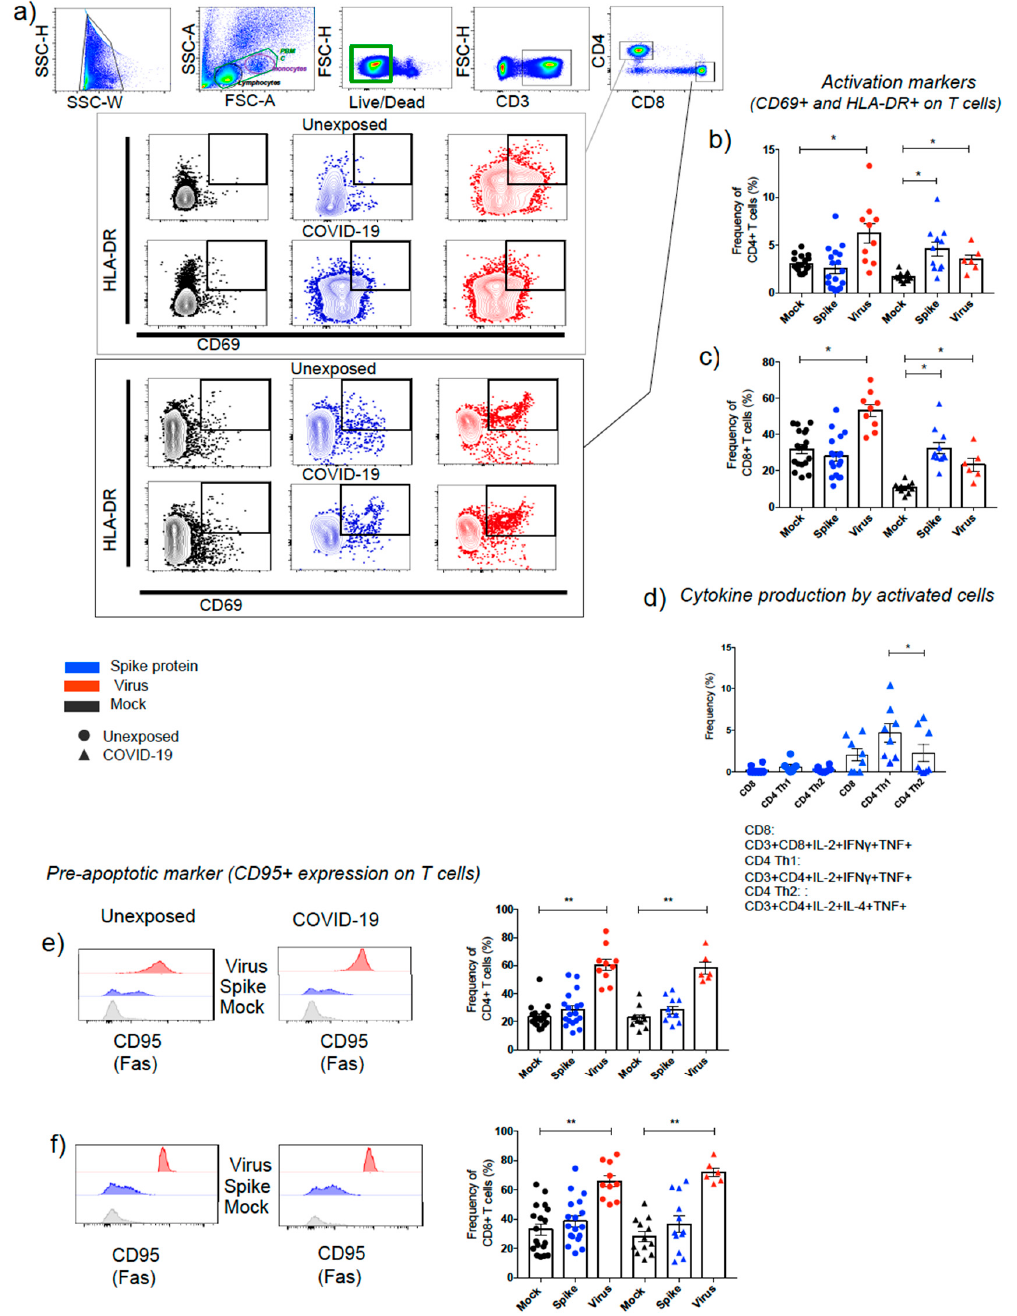
Figure 3. SARS-CoV-2 effects on lymphocytes T activation and pre-apoptosis. Gate strategy to define the subpopulations using dot plot FSC vs. SSC (green dashed line represents PBMC, purple line is the monocytes, and black line is the representation of lymphocytes. Gate to define total live PBMCs are represented with green line (FSC-H vs. Live/Dead). After gating live CD3 + T cells, it was possible to set activated T cells (CD4 + and CD8 + ), showing nonstimulated (black), stimulated with spike protein from SARS-CoV-2 (blue), and exposed with live virus (red) ( a ). Percentages obtained from unexposed and COVID-19 displaying data for CD4 + ( b ) and CD8 + T cells ( c ) activated by antigens. The intracellular staining assays with spike protein is showing CD8 + T lymphocytes producing IL-2, TNF and IFN-gamma, as well as CD4 + subsets, CD4 + Th1 and CD4 + Th2 with their main representative cytokines production by those cells in both groups, unexposed and SARS-CoV-2 exposed (COVID-19) ( d ). The expression of pre-apoptotic marker (CD95 + ) on CD4 + ( e ) and on CD8 + T cells ( f ) is displayed. The data are representative of 2–5 different experiments. * p < 0.05, ** p < 0.01, and *** p < 0.001.